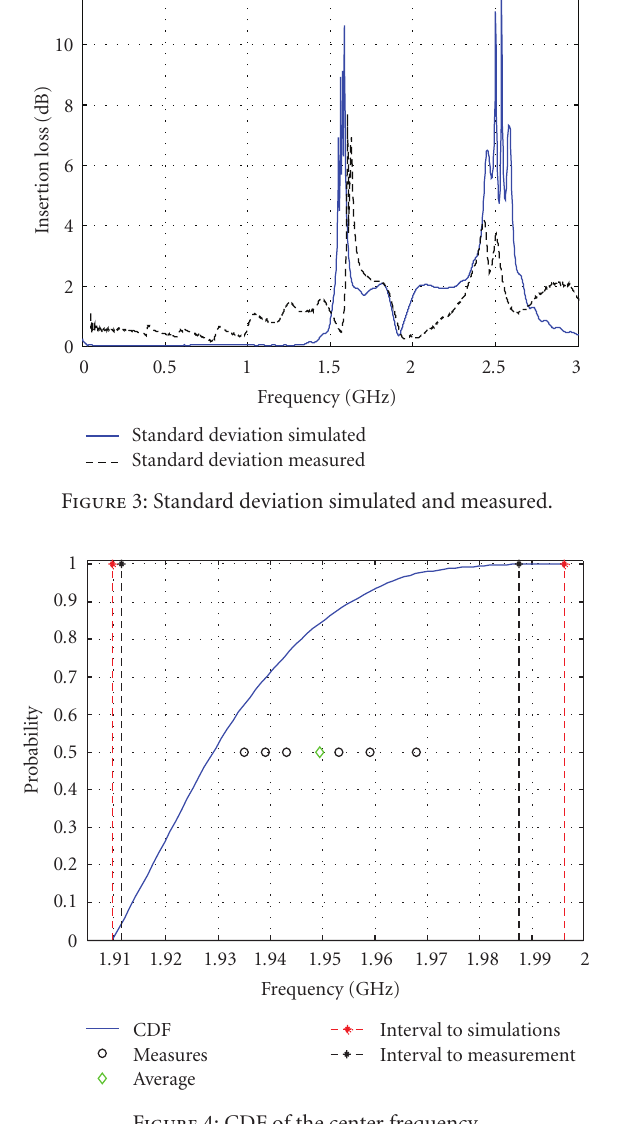
Figure 4: CDF of the center frequency.